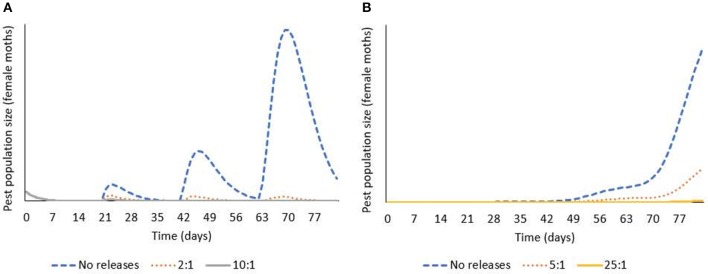
Deterministic modeling shows releases of OX4319L males suppress pest populations of P. xylostella, in which bi-weekly releases of OX4319L male moths are conducted from day 0. (A) Response of pest population growth after a single immigration event (on day 0) to releases of OX4319L males at different initial over-flooding rates (2:1 and 10:1), and no releases of OX4319L males. (B) Response of pest population growth to gradual immigration (days 1–21) to releases of OX4319L males at different initial over-flooding rates (5:1 and 25:1), and no releases of OX4319L males.